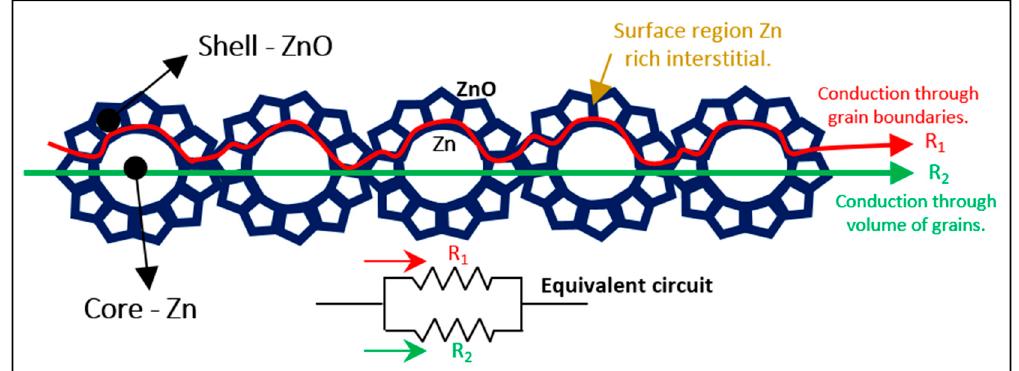
Figure 14. A model of conductivity through the crystal in the film. Two possible paths for conduction: intergrain (R 1 ) and through the volume of the grains (R 2 ).